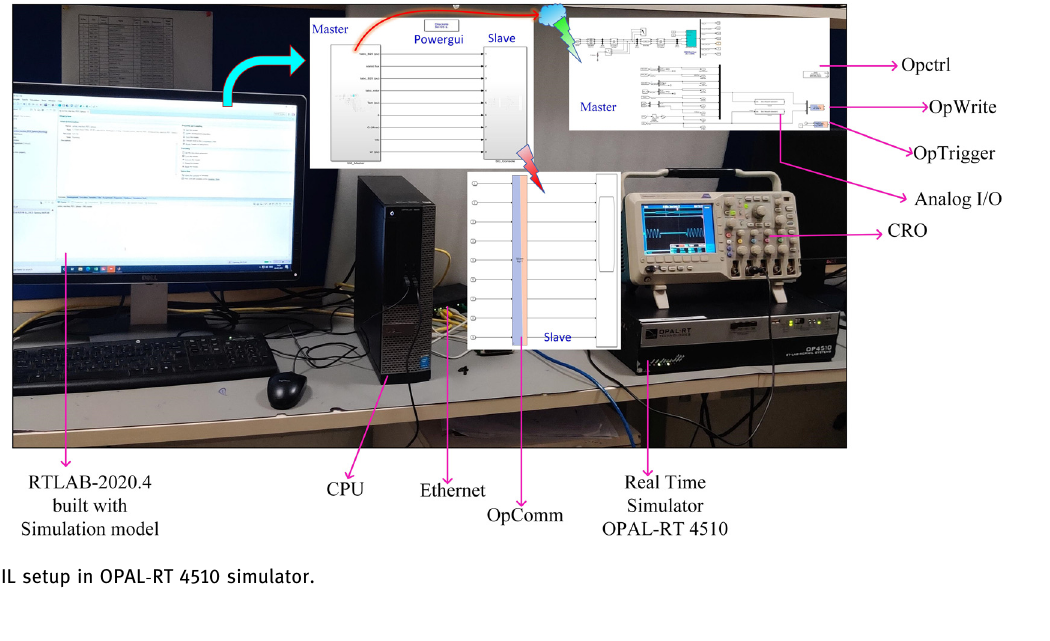
Table 2: 1.5 MW DFIG - based WT parameters Symbol